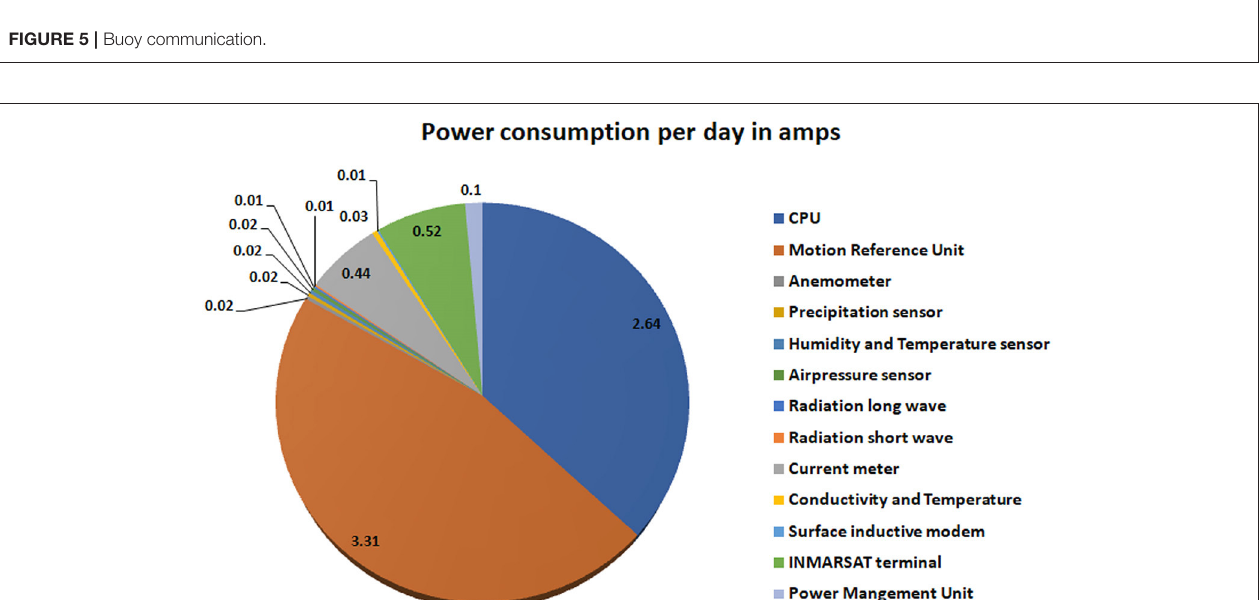
FIGURE 6 | Power consumption of the buoy systems.